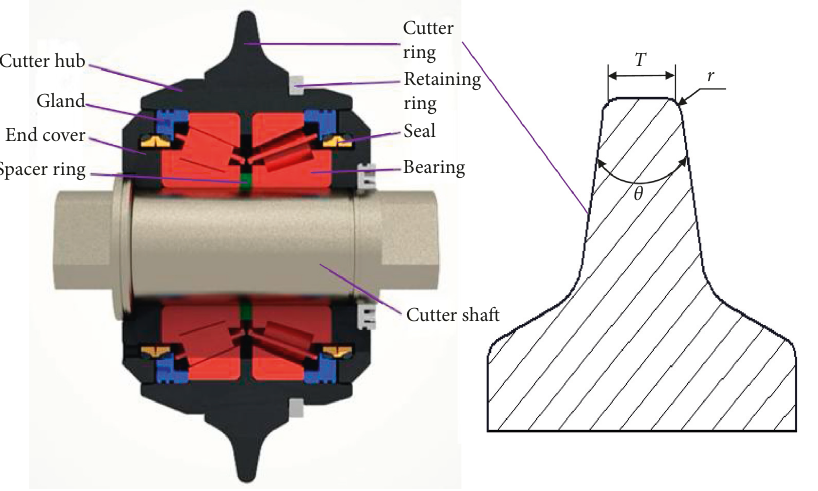
Figure 1: Sketch of disc cutter and cutter